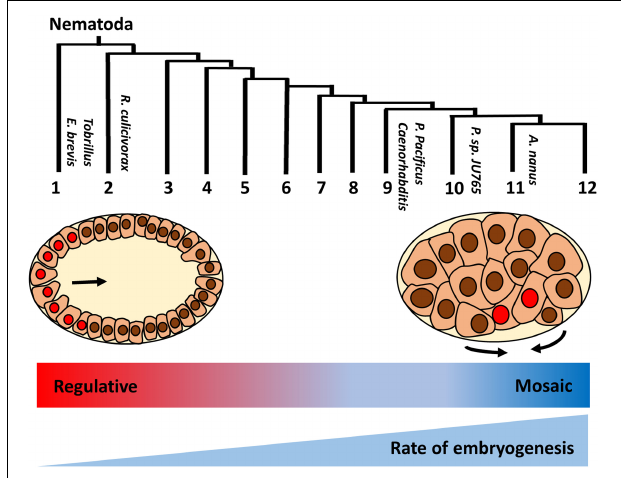
FIGURE 2 | Variation in early embryogenesis in Nematoda. Nematodes are classified into 12 clades based on rDNA sequence (Holterman et al., 2006). Basal Tobrillus undergoes a “canonical” protostome-like gastrulation characterized by invagination of eight endoderm precursors (red nuclei) at the anterior blastopore during 64 cell-stage. Gastrulation in more highly derived nematodes is driven by apical constriction of endoderm precursors at the postero-ventral surface of 28 cell-stage embryo (adapted from Joshi and Rothman, 2005). Unlike species in the early branching clades, in which cell fates are plastic and rely on external signals (“regulative” development), cell lineages are largely fixed during early division (“mosaic development”) in more derived species. In addition, developmental rate is faster in the more derived clades. Thus, it is proposed that heterochronic and heterotopic shift in the developmental program drive the evolution of early embryogenesis in